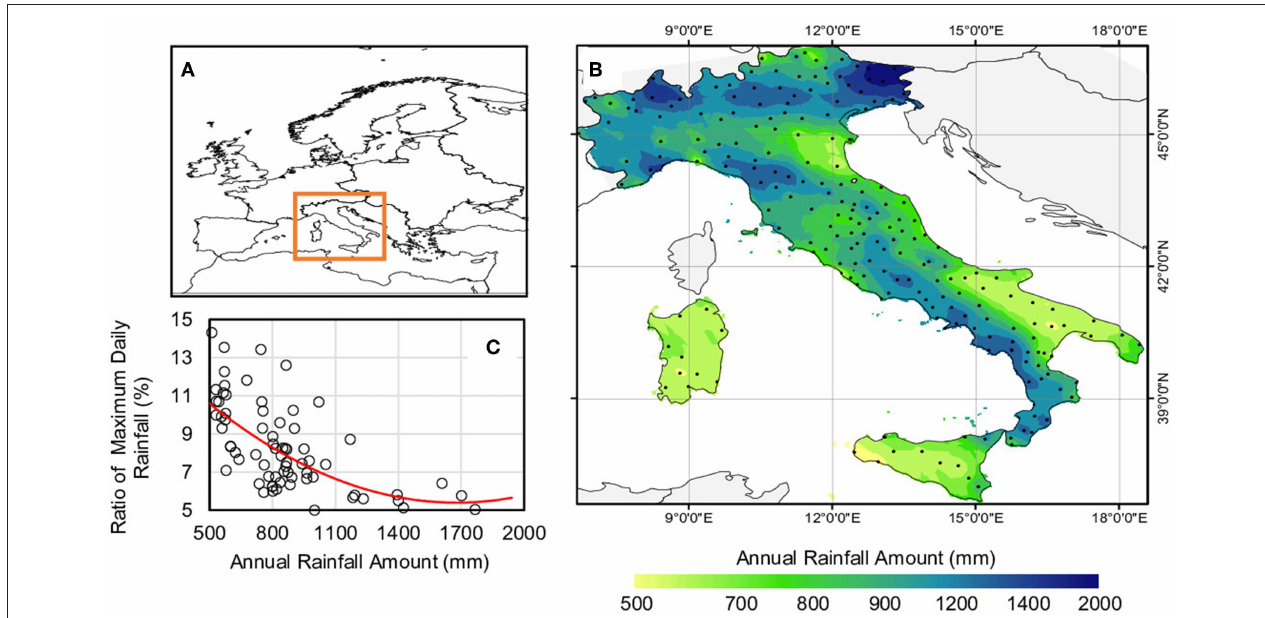
FIGURE 1 | (A) Overview map of the study area. (B) The spatial pattern of mean annual rainfall amount overlaid with stations location, and (C) Ratio of maximum-recorded daily rainfall vs. mean annual precipitation for Italy during the period